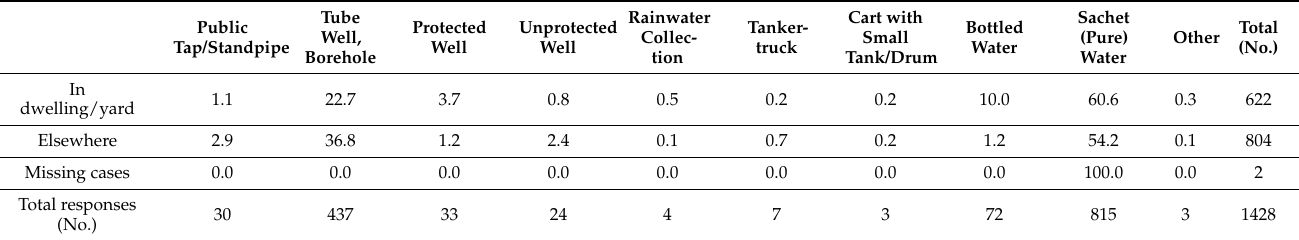
Table 4. Water sources by location (Lagos State, % respondents).